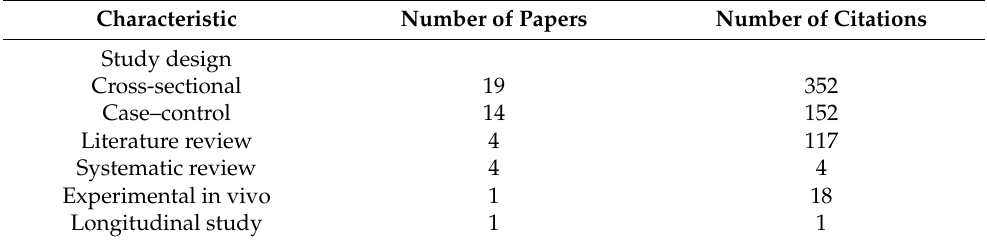
Table 3. Types of studies of the selected articles.